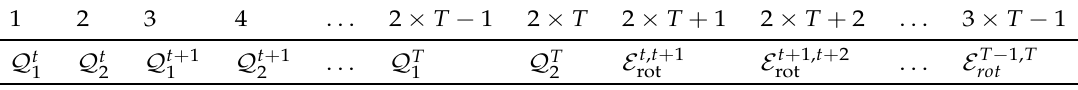
Table 2. The rule of human motion feature